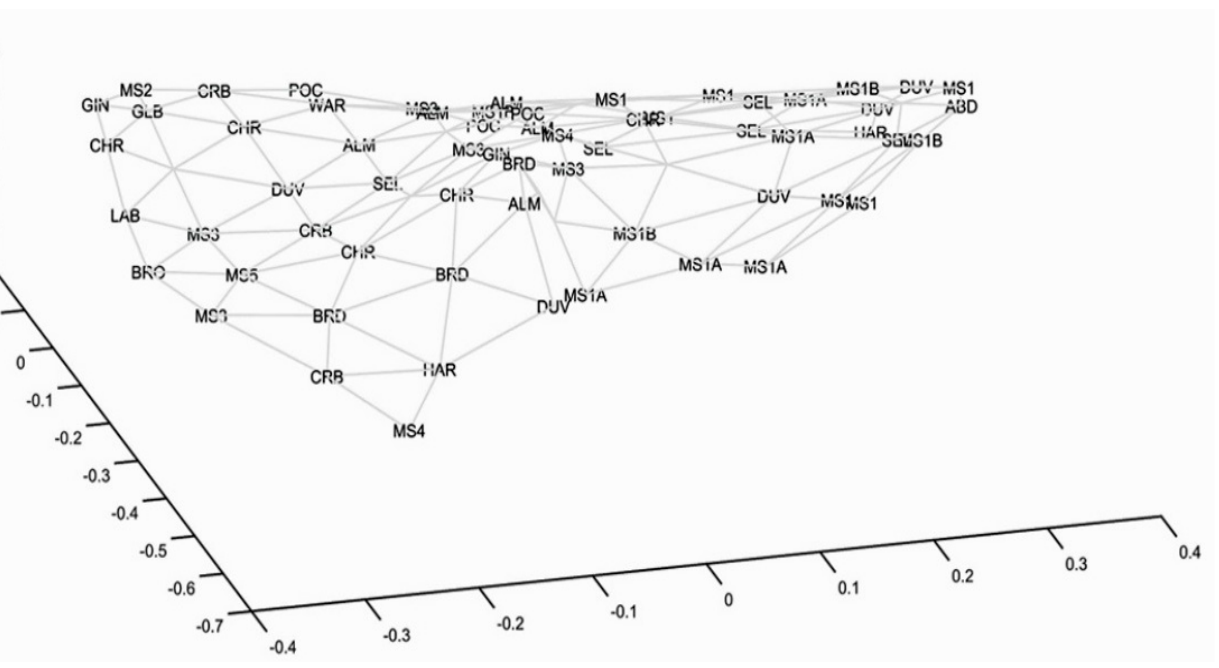
Figure 15. SOM map projection